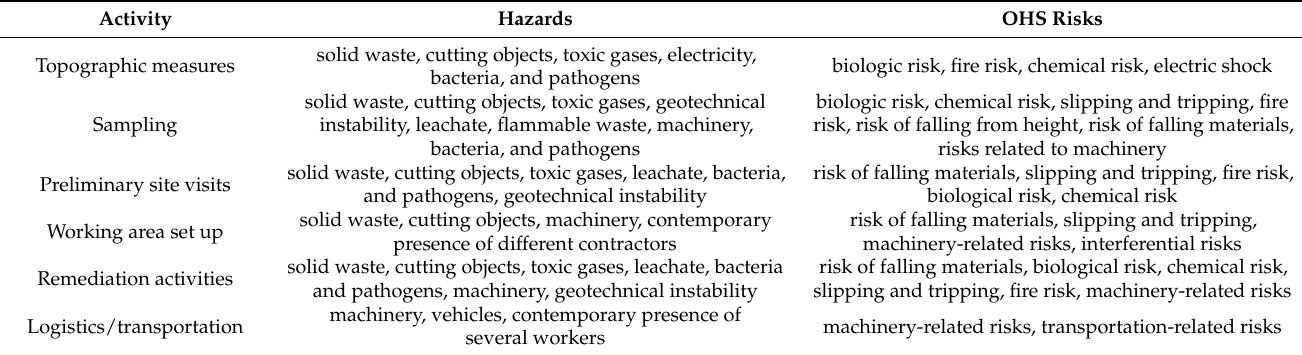
Table 2. Risk exposure per main activity carried out in